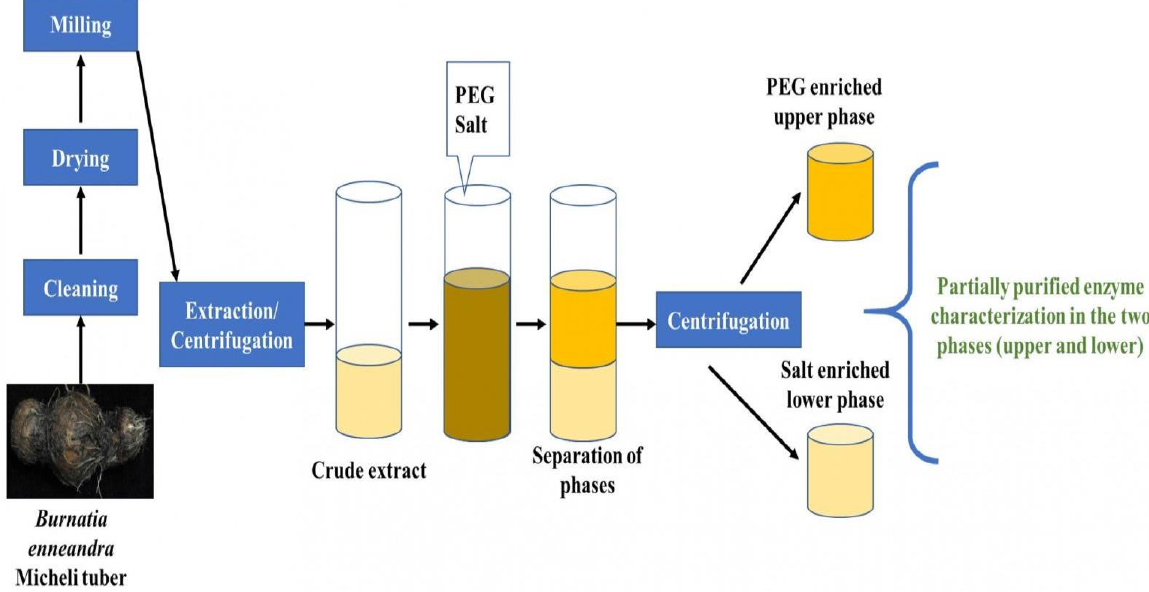
Figure 7. Aqueous two-phase system (ATPS) in the separation and purification process